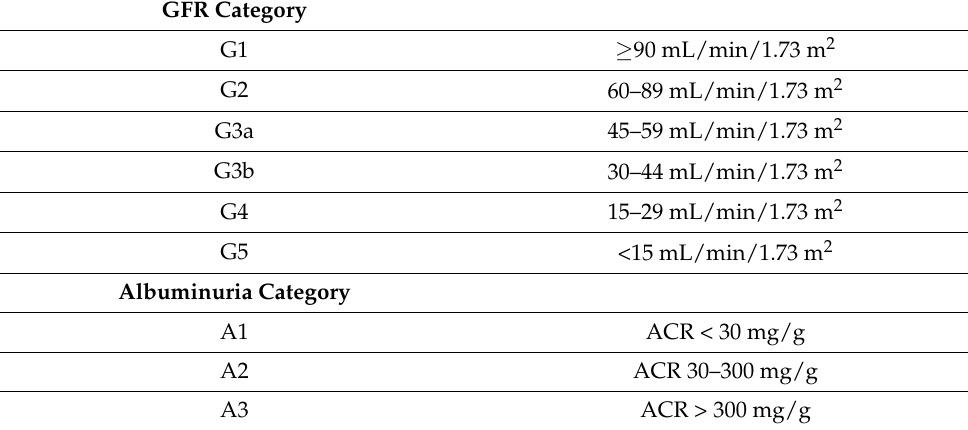
Table 1. Staging of chronic kidney